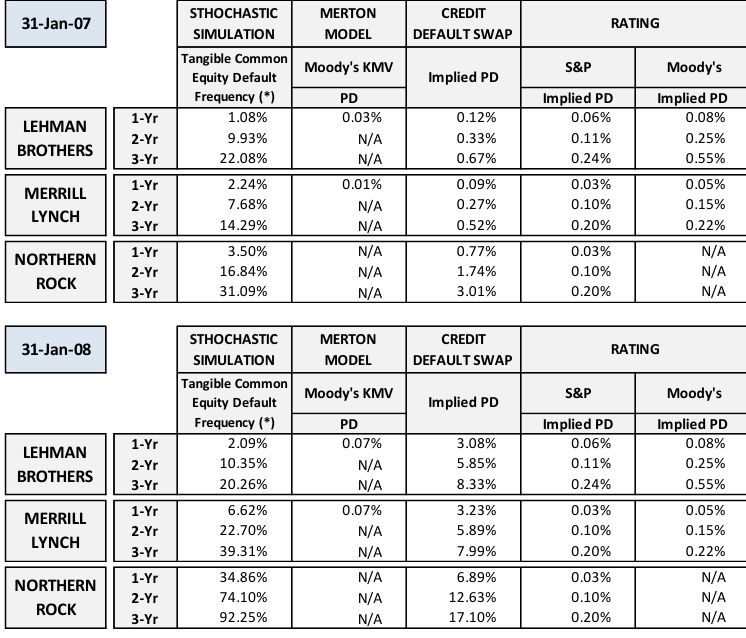
Figure 11. Default risk comparative back-testing analysis. (Source of CDS, KMV data, rating: Bloomberg, Moody’s KMV, Standard & Poor’s) .